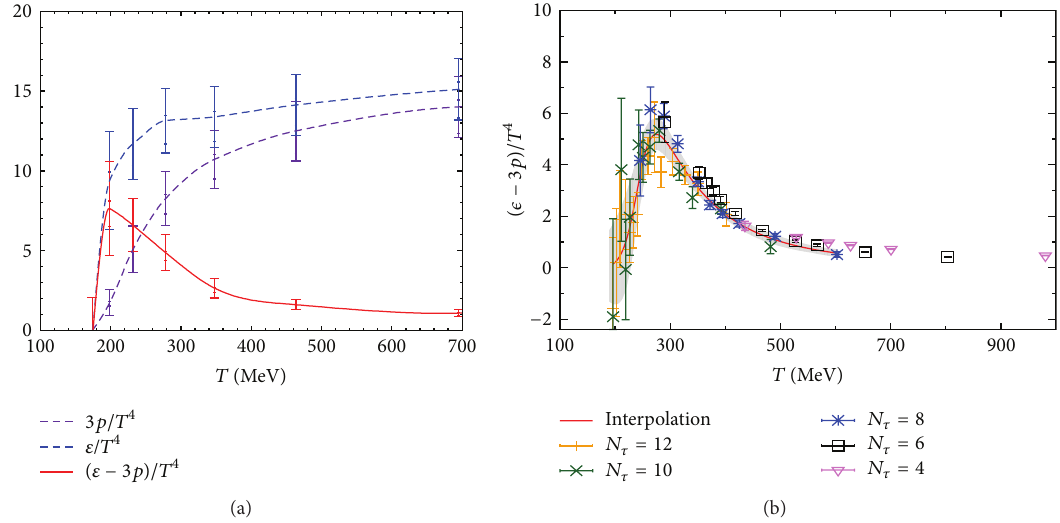
Figure 4: The results for the pressure, energy density, and the trace anomaly with clover-improved Wilson fermions on a 32 3 ×8 lattice, from [51] (a) and the trace anomaly data with the twisted mass Wilson fermions, from [52] (b).